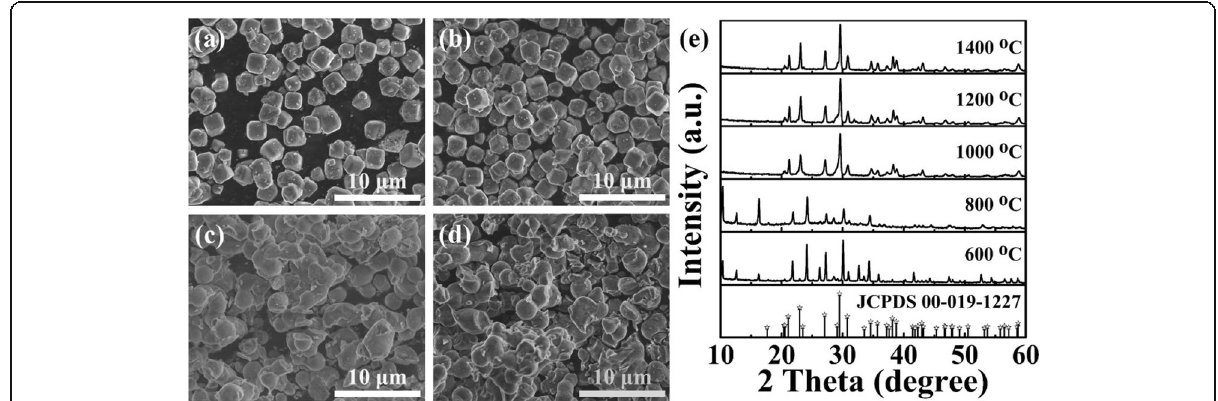
Fig. 2 SEM images of zeolite-3A: 1.3 wt% Eu phosphors sintered at 600 °C ( a ), 800 °C ( b ), 1000 °C ( c ), and 1200 °C ( d ), respectively. e XRD patterns of zeolite-3A: 1.3 wt% Eu phosphors sintered at different temperatures, respectively